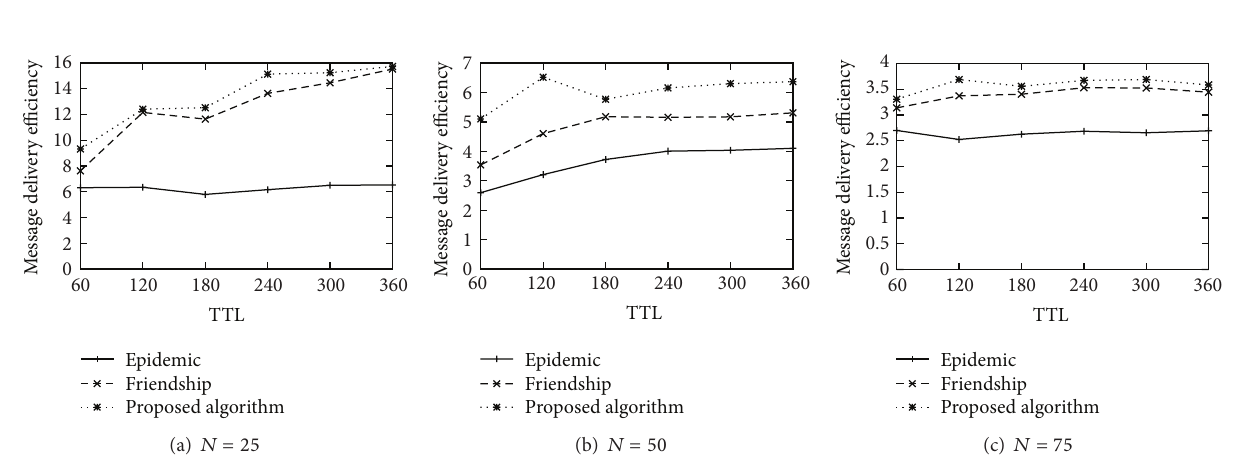
Figure 4: Delivery Cost.